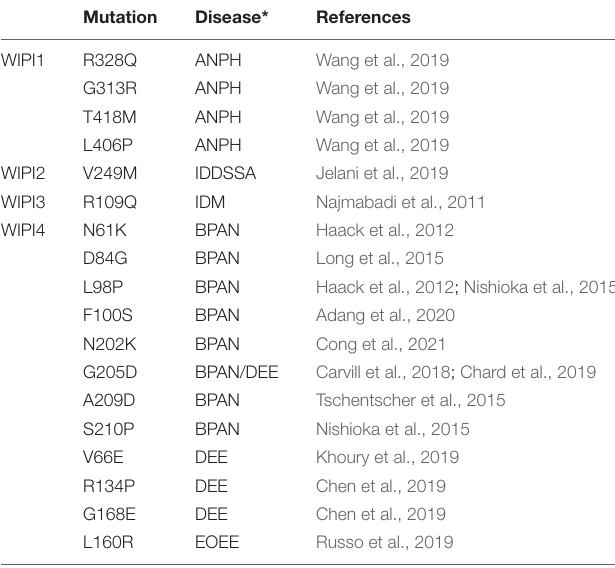
TABLE 1 | Missense mutations in WIPI proteins and associated